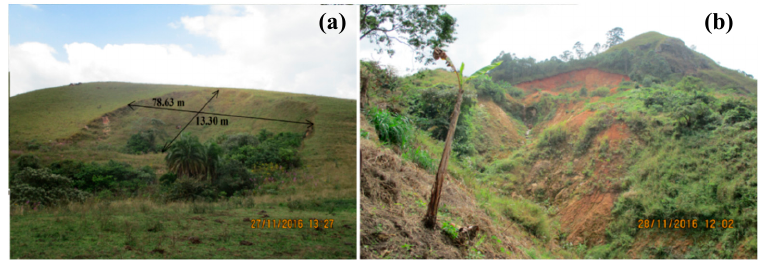
Figure 4. Deep-seated translational landslides observed at Mbingo: ( a ) Translational, ( b ) translational failure transformed into debris flow.